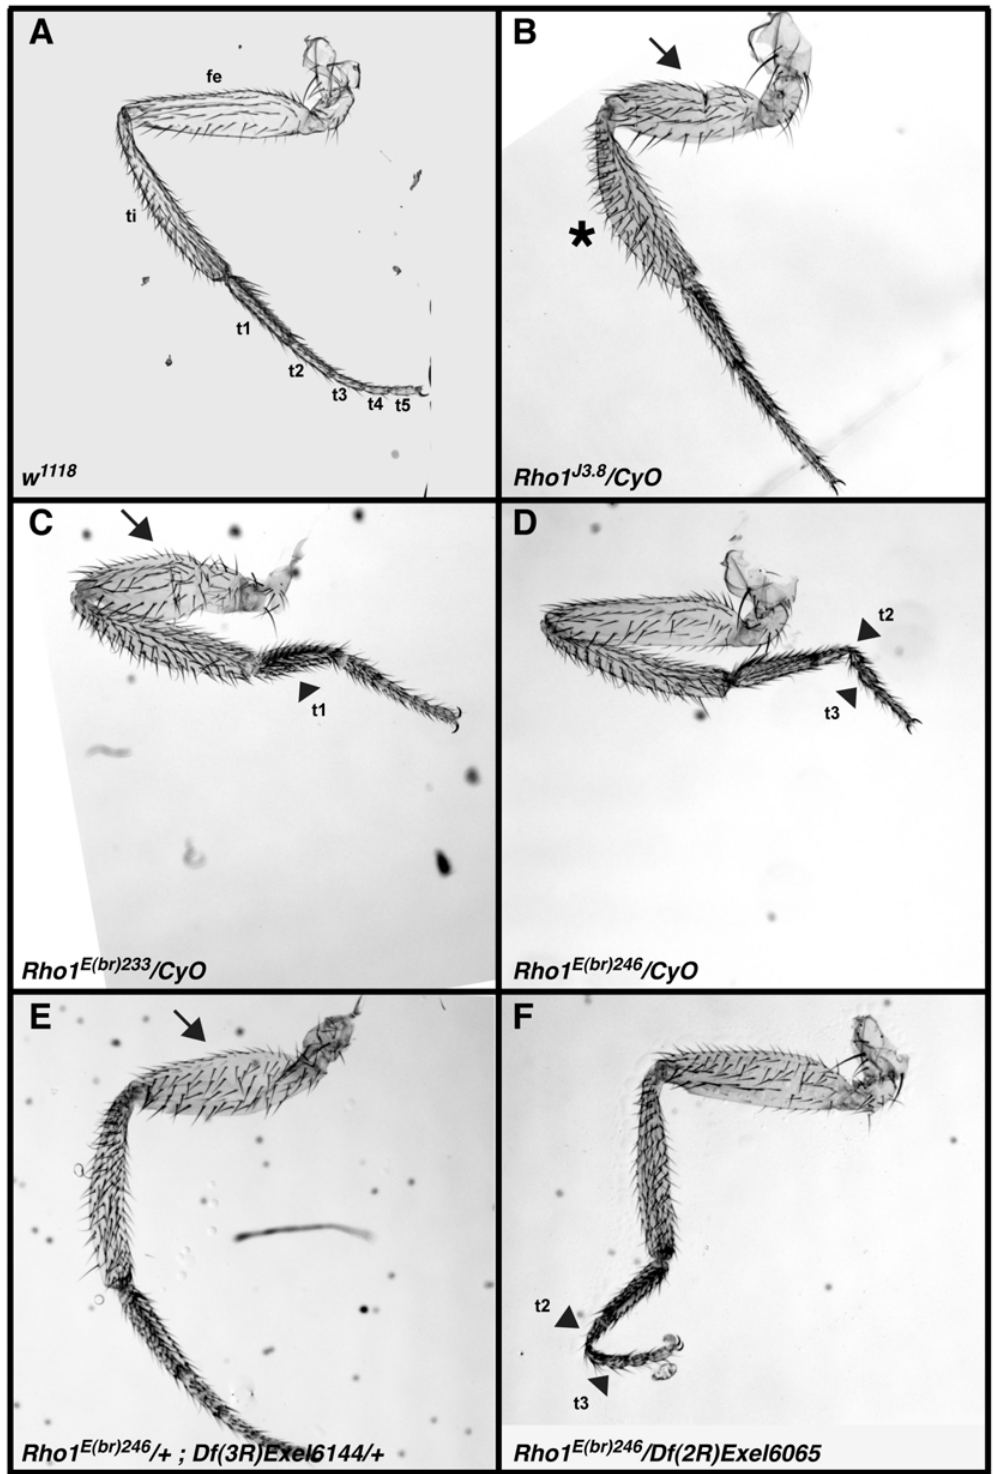
Figure 1. Representative malformed leg phenotypes in animals heterozygous for mutations in Rho1 , or doubly heterozygous for mutations in Rho1 E(br)246 and specific Rho1 -interacting deficiencies. Brightfield photomicrographs of representative adult legs from the third thoracic segment of w 1118 (A), Rho1 J3.8 /Cyo (B), Rho1 E(br)233 /CyO (C), Rho1 E(br)246 /CyO (D), Rho1 E(br)246 / + ;Df(3R)Exel6144/ + (E), and Rho1 E(br)246 /Df(2R)Exel6065 (F). Femur (fe), tibia (ti), and the five tarsal segments (t1-t5) are labeled in (A). Some animals show short, fat femurs (arrows in B, C and E) or tibias (asterisk in B), whereas others show tarsal segments that are short and fat, or are long and thin and occasionally show severe bends (arrowheads in C, D and F). Note that malformations in all leg segments are seen with each Rho1 allele, and in the interaction between Rho1 alleles and specific Rho1 -interacting deficiencies.